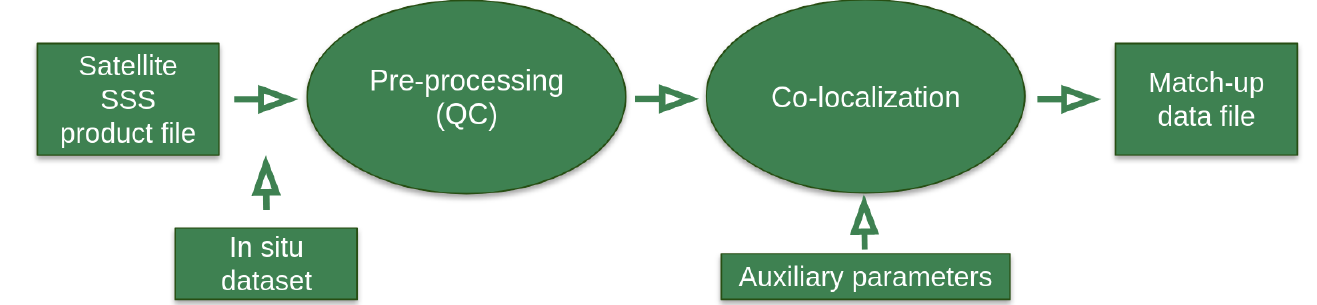
Figure 2. Flow chart of the match-up